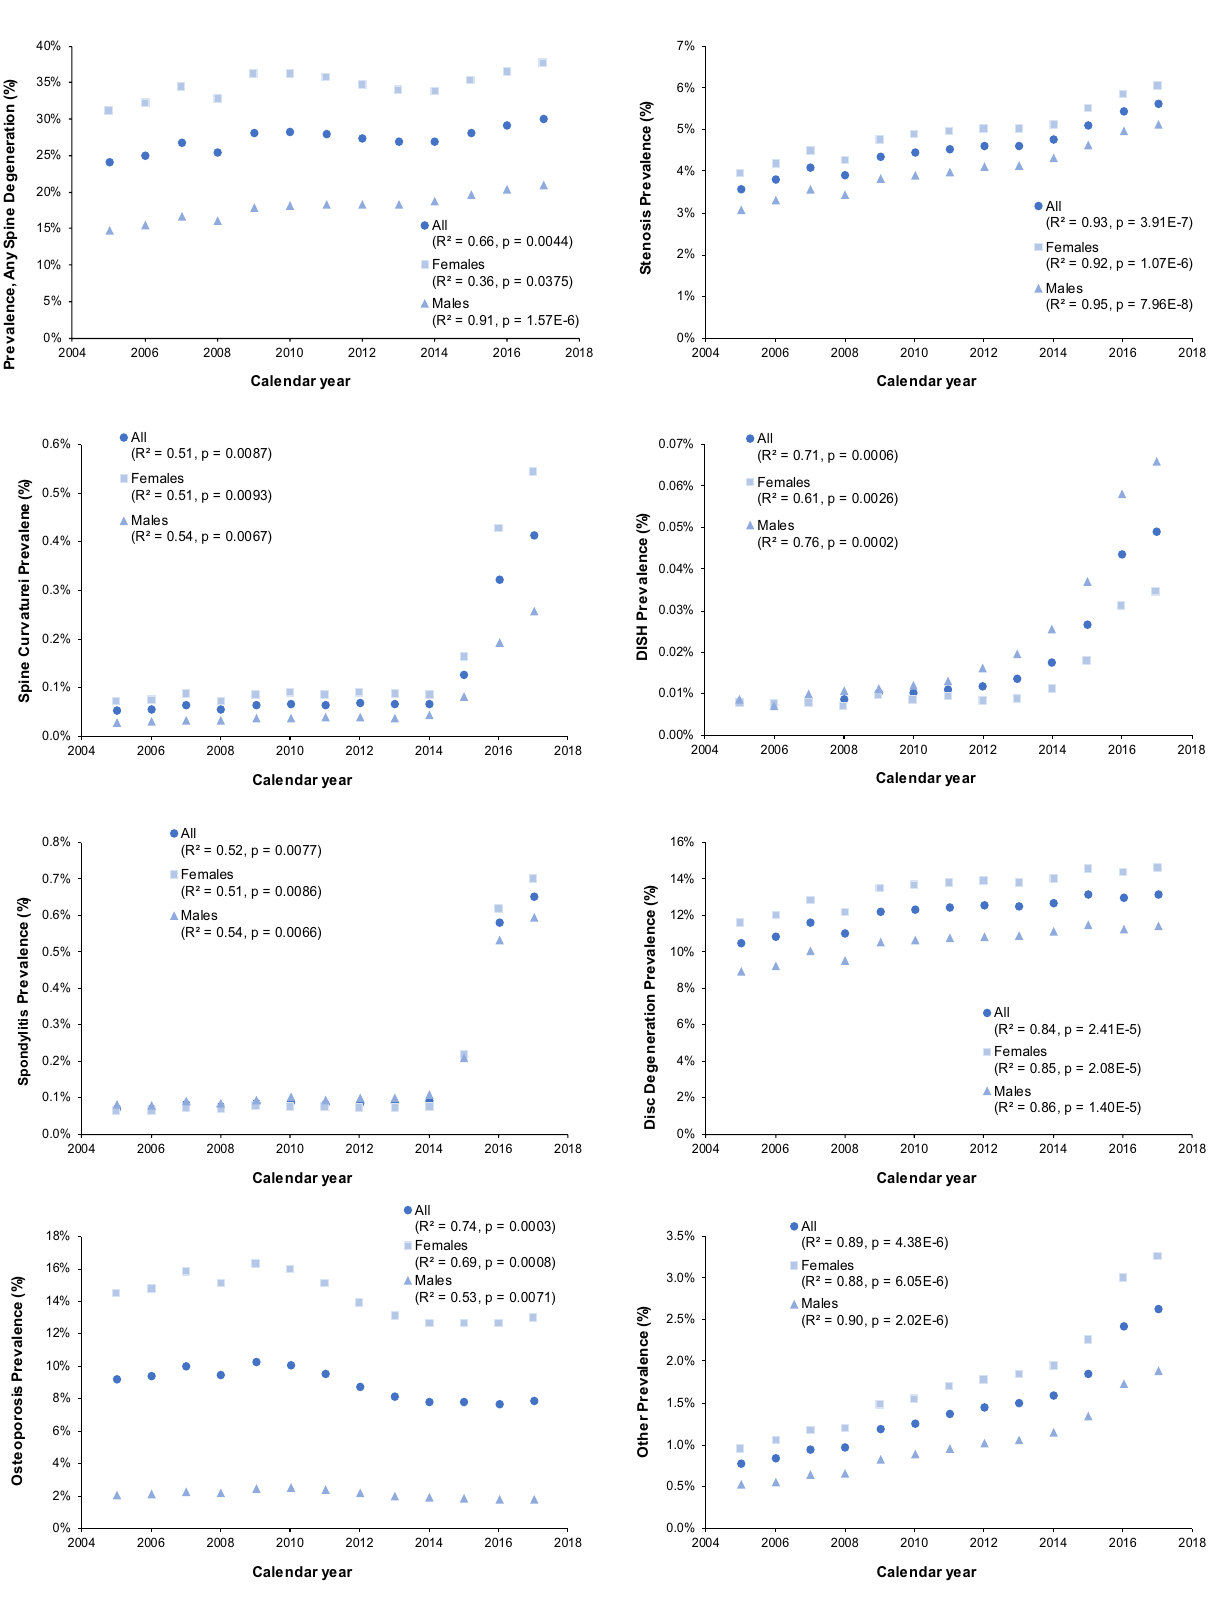
Figure 2. Spine degeneration diagnosis prevalence by type, calendar year, and sex. Pearson’s Correlation coefficients and p values are